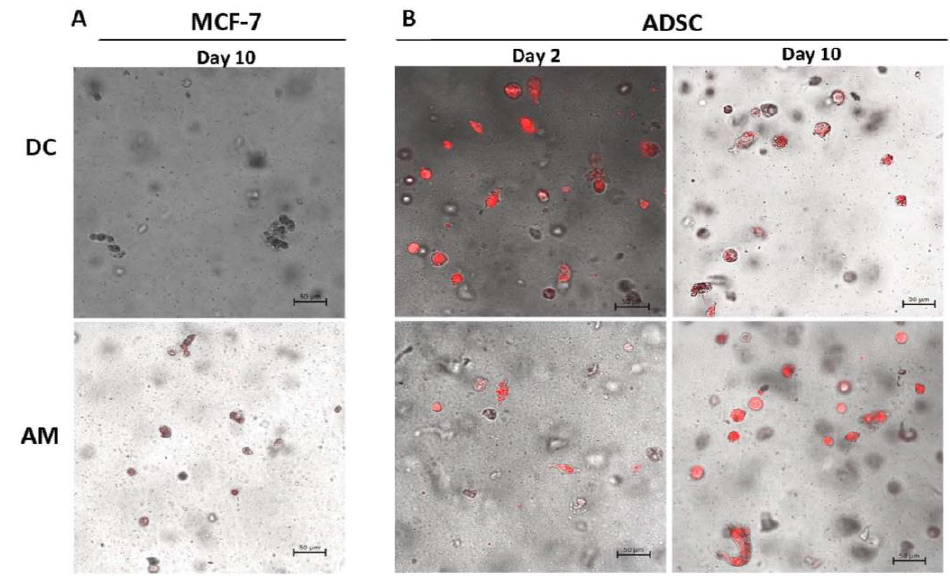
Figure 7. 3D monoculture Nile Red staining of lipids for ( A ) MCF-7 and ( B ) ADSC with DC and AM. Scale bar = 50 µm.